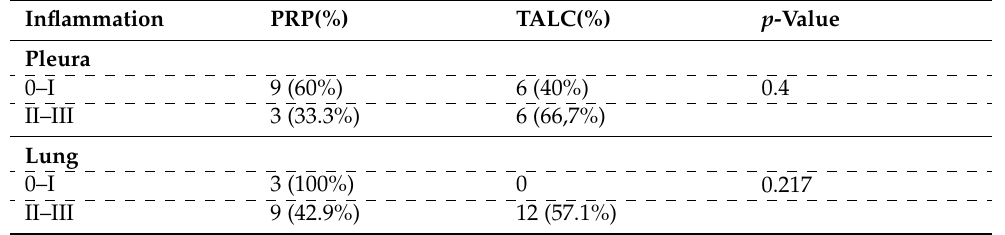
Figure 11. Parietal pleura inflammation at 3 vs. 6 days of talc. The univariate analysis for inflammation is shown on Table 2. The univariate analysis for inflammation is shown on Table 2. Table 2. Univariate analysis for Table 2. Univariate analysis for inflammation.